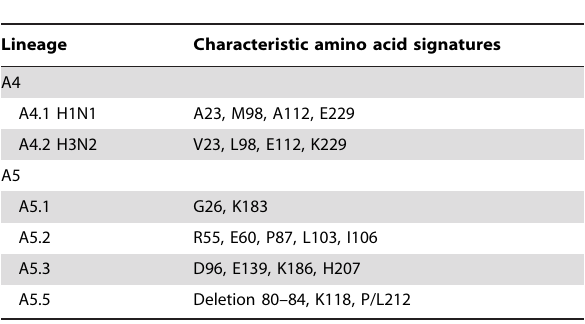
Table 4. Characteristic amino acid signatures in the classification of major avian and human host